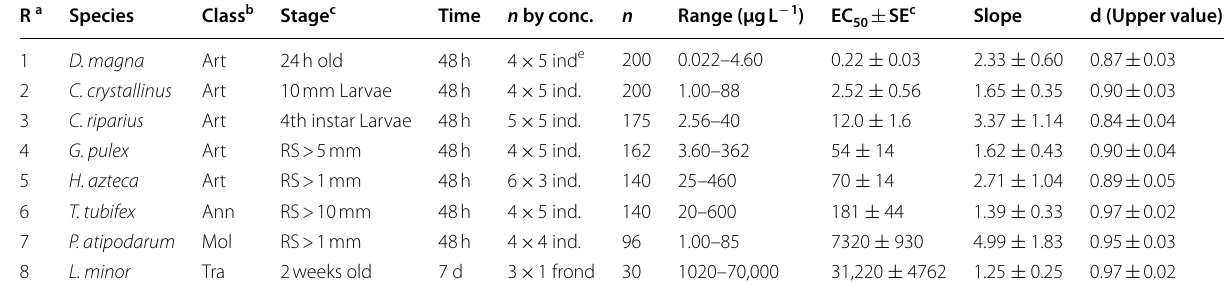
a Rank order b Arthropoda (Art), Annelida (Ann), Mollusca (Mol), Tracheophyta (Tra) c Random size (RS) d Standard error